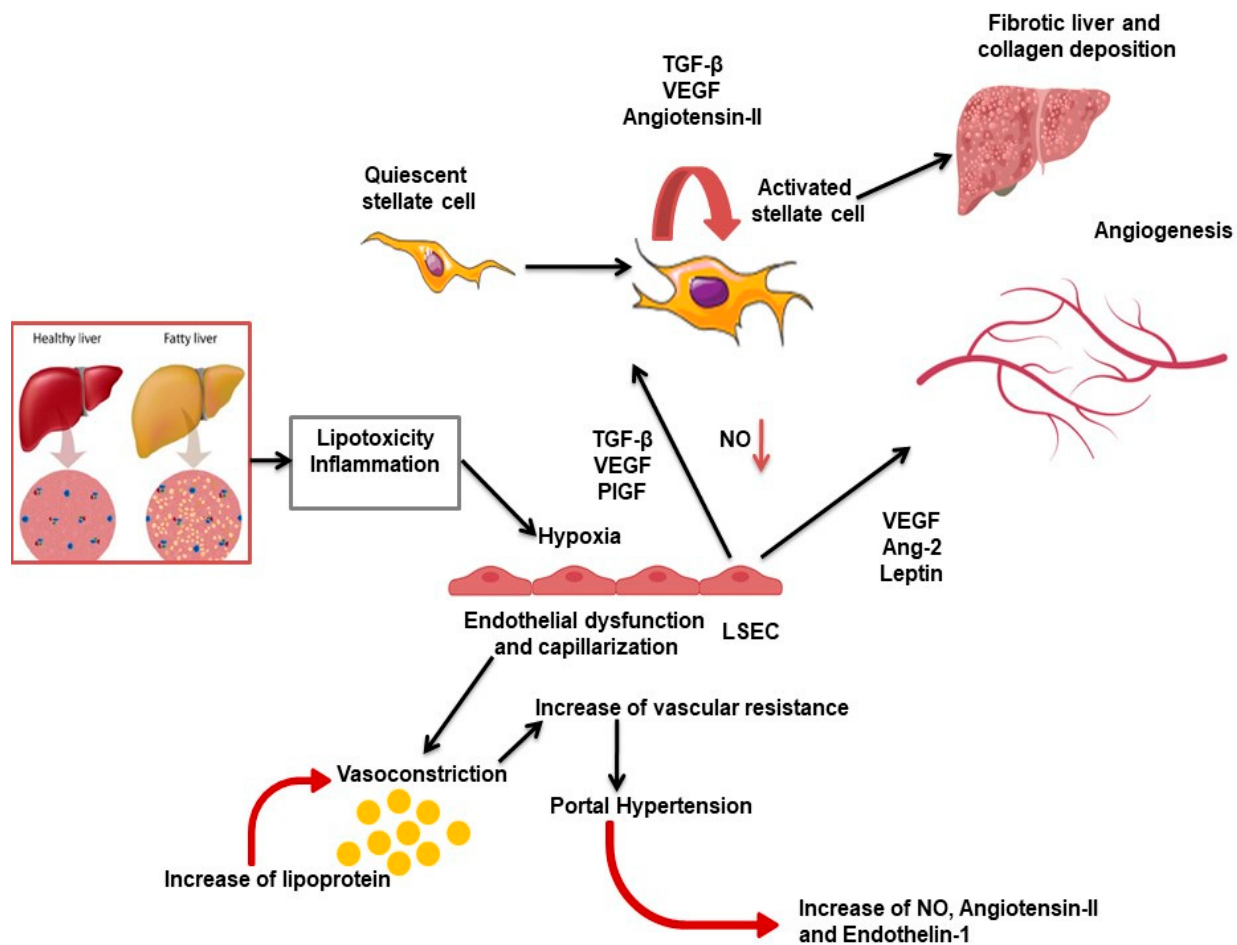
Figure 1. This figure summarizes the common pathways of pathological angiogenesis in NAFLD/NASH discussed in this review. Hepatic steatosis, lipotoxicity, hypoxia, and inflammation induce morphological changes in sinusoidal endothelial cells (LSECs), resulting in endothelial dysfunction and capillarization. LSECs release fibrogenic and angiogenic mediators, while reducing the production of nitric oxide (NO), thus activating hepatic stellate cells (HSCs). At the same time, angiogenic factors released by LSECs and HSC induce hepatic angiogenesis.